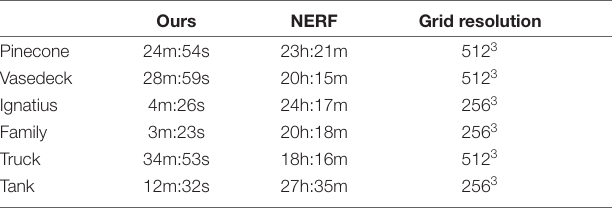
TABLE 2 | Reconstruction times for the 360 ◦ scenes.